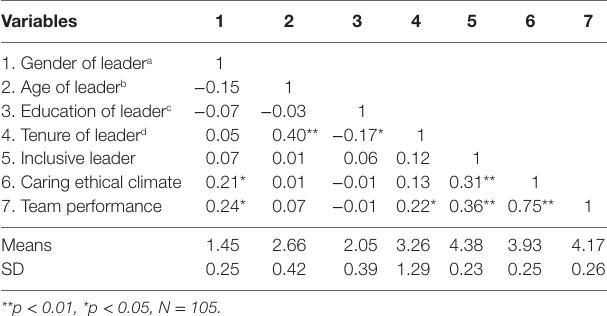
TaBle 1 | Means, SDs, and correlations at the team level.